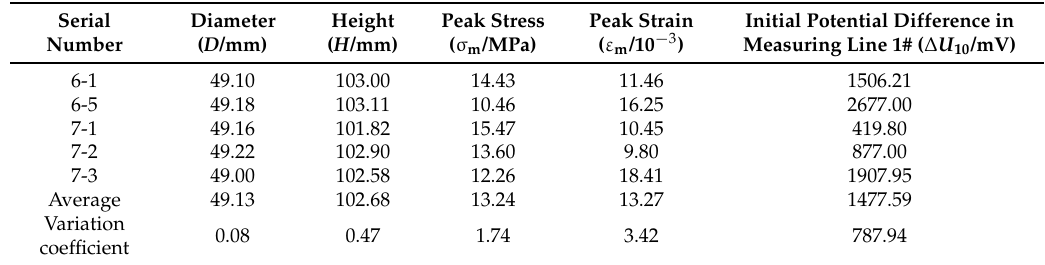
Table 1. Test results of rock samples parallel to the bedding direction in uniaxial compression test.